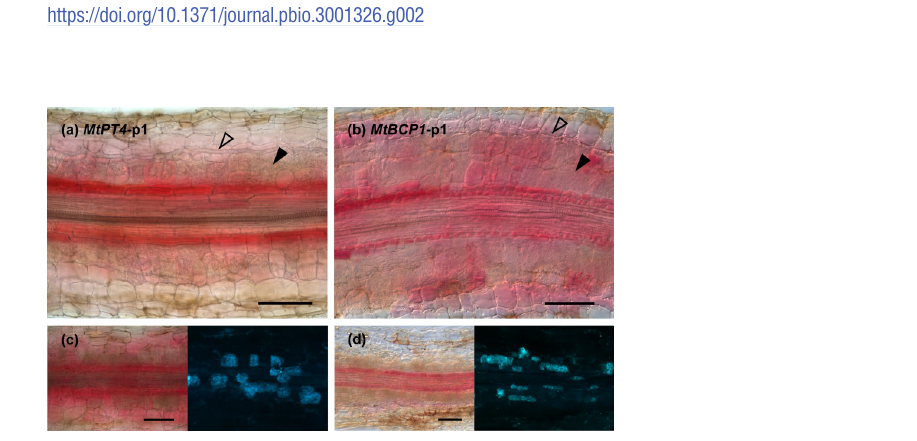
Fig 3. Betalain accumulation is observed at different intensities in different tissue layers and appears higher in the endodermal cells adjacent to arbuscule-containing cortical cells. Root sections of Medicago truncatula expressing MtPT4 -p1 (a and c) and MtBCP1 -p1 (b and d) 4 weeks after inoculation with Rhizophagus irregularis . (c and d) Left: Betacyanin pigments are visible in red; right: WGA-FITC staining of fungal structures in blue. Open arrows mark internal hyphae, and filled arrows signal cells containing arbuscules. Scale bar, 100 μ m. WGA, wheat germ agglutinin.